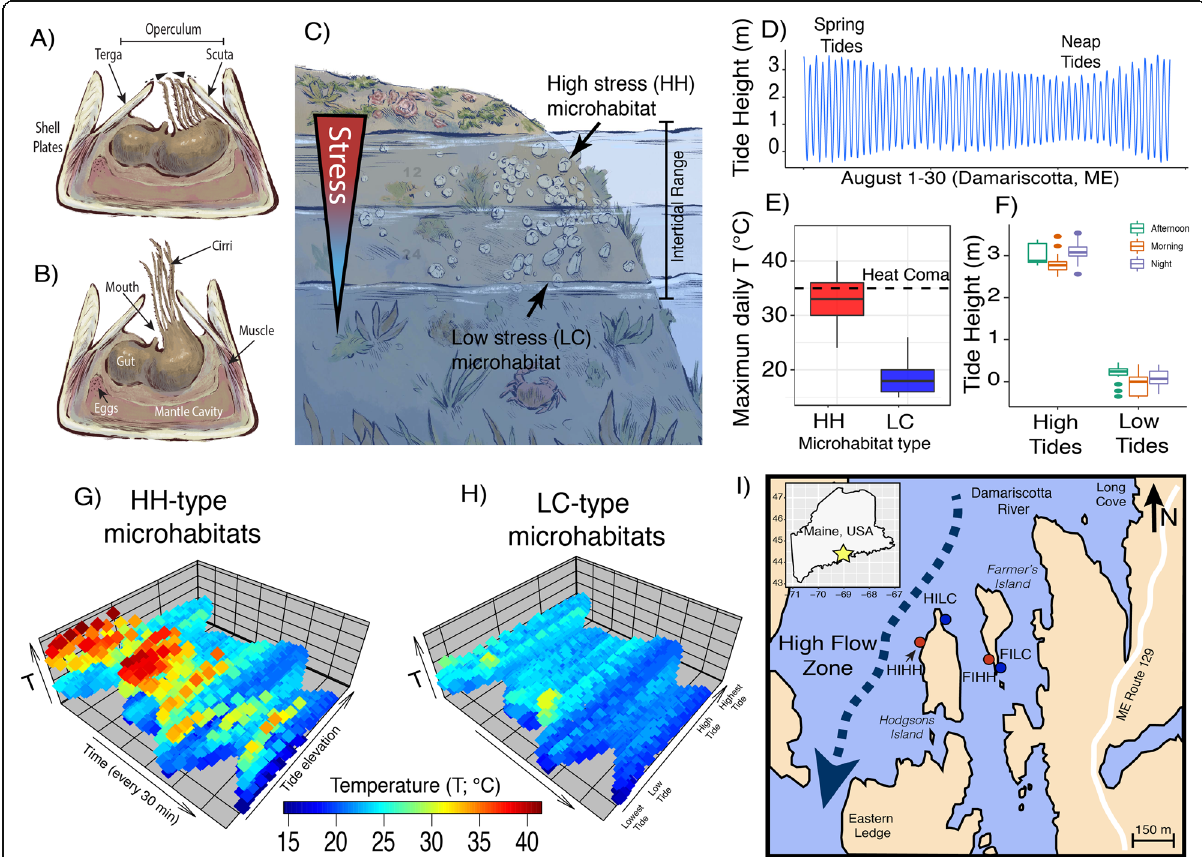
Fig. 1 Model of barnacle, its surrounding environment, and map of collection site. a Diagram of a barnacle with cirri retracted and the operculum closed which occurs during periods of emersion. b Diagram of a barnacle with extended cirri during filter feeding. c Model of intertidal stress across the rocky intertidal. d Measurements of tidal height for the month of August 2015 in Damariscotta, ME (NOAA tide station 8416731). e Measurements of maximum daily temperatures across collection sites for sites high temperature sites (High Hot-HH) and low temperature sites (Low Cold-LC) (shown in panel c ). Data was collected in the summer of 1994 and published by Schmidt and Rand [23]. The horizontal dashed line indicates the heat coma point. f Range of tidal height for the high and low tides in August 2015 at the Damariscotta River, ME at mornings, afternoons, and nights. g High-resolution temperature profile of HH habitats as a function of tidal range and summertime in Rhode Island. Data was collected in the summer of 2018 and published by Nunez et al. [24, 25]. The temperature axes show temperatures collected every 30 min. The time axis shows times from July to August. The tidal range axis represents the tidal height at the moment of temperature collection (NOAA tide station 8452660, Newport, RI). The oscillations in the tidal range amplitude are produced by the lunar cycle, and the points of maximum thermal stress coincide with the lowest low tides. h Same as G but for LC habitats. i Map of the Damariscotta River in Maine with sampling localities indicated. Barnacles were collected from Hodgson ’ s Island (HI) and Farmer ’ s Island (FI). There are four sites: Farmers Island Hot High (FIHH), Farmers Island Low Cold (FILC), Hodgsons Island High Hot (HIHH), and Hodgsons Island Low Cold (HILC). Red dots indicate upper tidal habitats with high sun